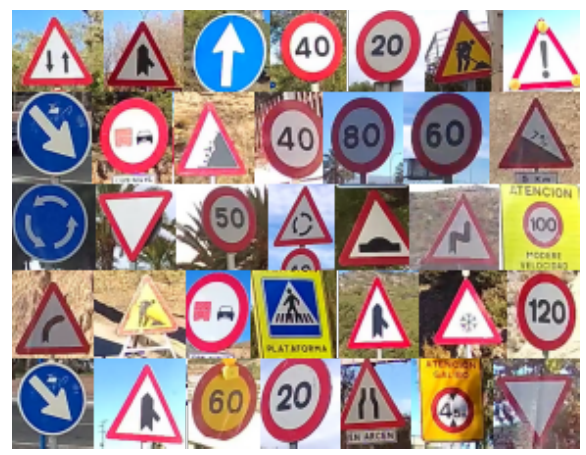
Figure 7. Image samples from the Traffic Signs Dataset